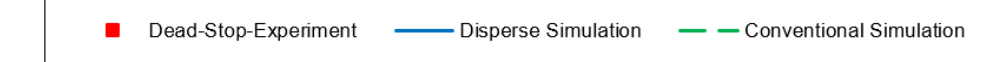
Figure A2. Comparison of measured versus simulated solids content for energy-transfer screw D = 30 mm with low back pressure ( a , b ) and high back pressure ( c – e ).